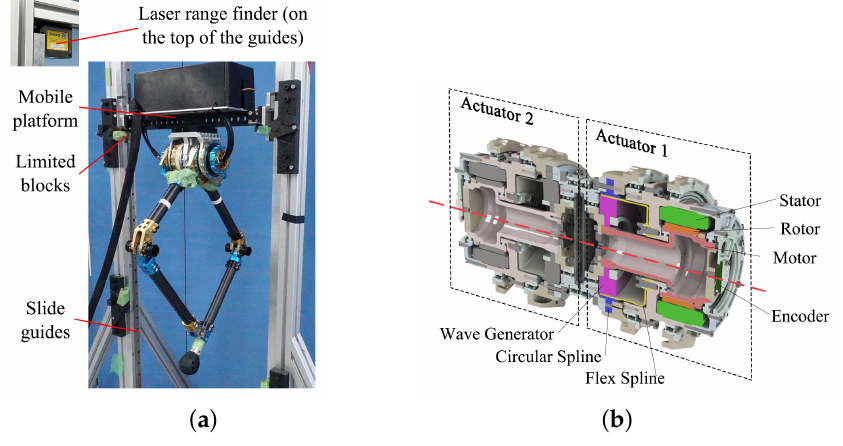
Figure 1. ( a ) Robot prototype; and ( b ) structural profile of actuation module.